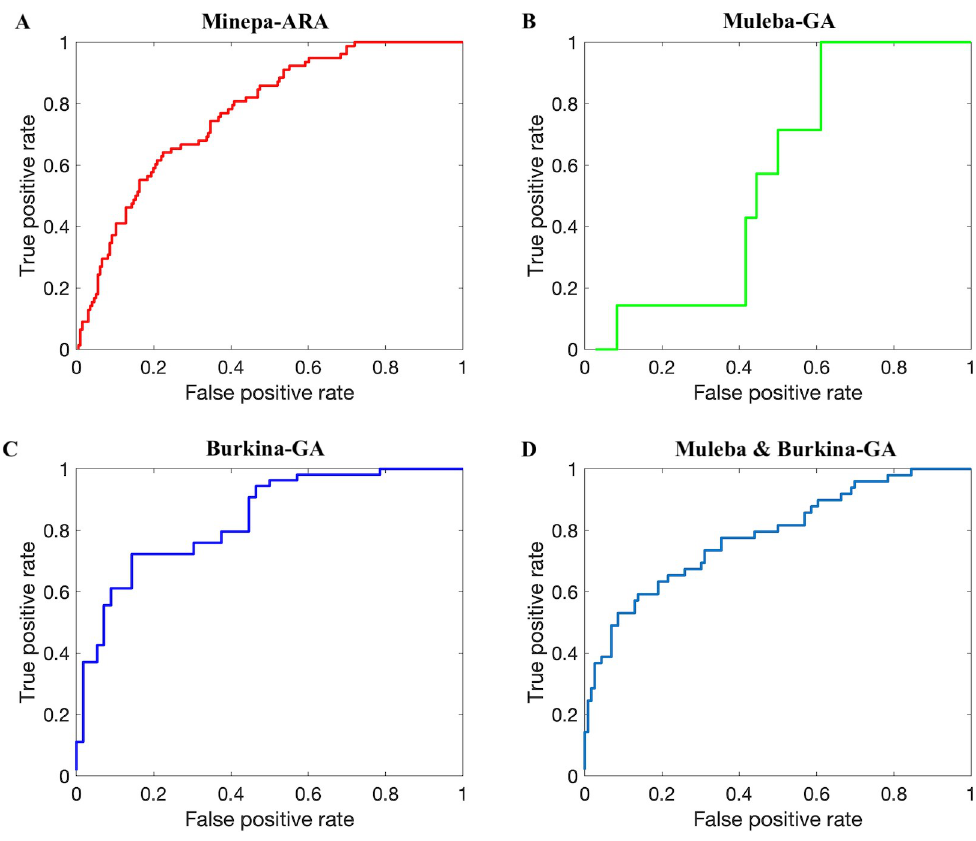
Fig 8. ROC curves (AUCs presented in the last row of Table 2) showing results when ANN models trained on 75% of spectra before the autoencoder was applied and tested on the remaining spectra (25%) (out of the sample testing). A, B, C, and D represent results for the Minepa-ARA, Muleba-GA, Burkina-GA, and Muleba-Burkina-GA (mosquitoes in Muleba-GA and Burkina-GA datasets combined) datasets, respectively. In each ROC curve, a threshold of 0.5 was used to compute true positive rate and false positive rate.